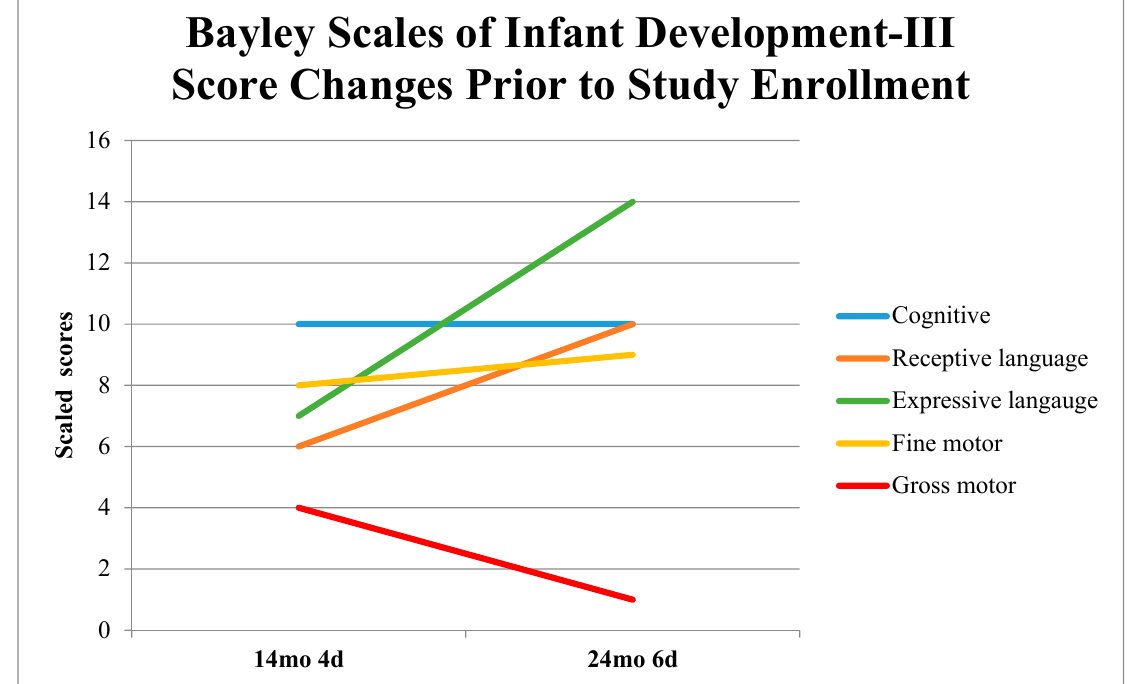
Figure 1. Bayley Scales of Infant Development-Third Edition Changes from 14 to 24 months Chronological Age. Changes in Bayley Scales of Infant Development, 3rd Edition, scores over 10 months as assessed at 14 and 24 months chronological age in NICU follow up clinic prior to study enrollment. mo = months, d = days. The scaled score population mean is 10 with a standard deviation equal to +/ − 3 [38].